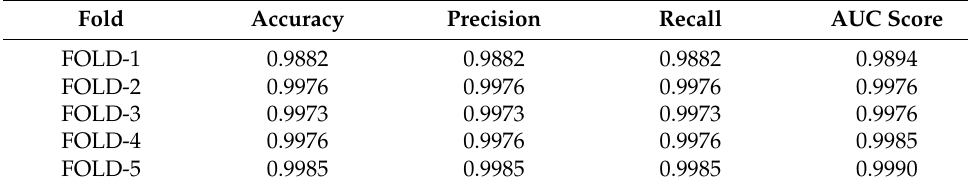
Table 6. The 5-fold cross validation results of the WSI dataset.